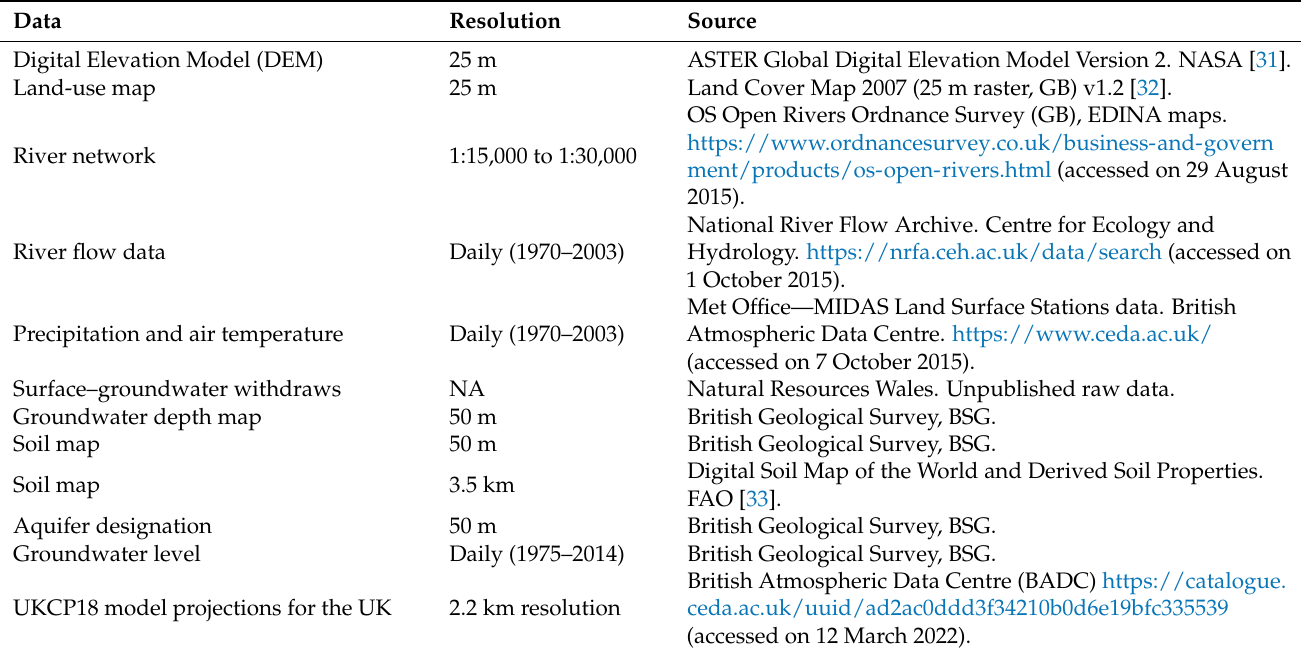
Table 1. Data collected for the hydrological model.